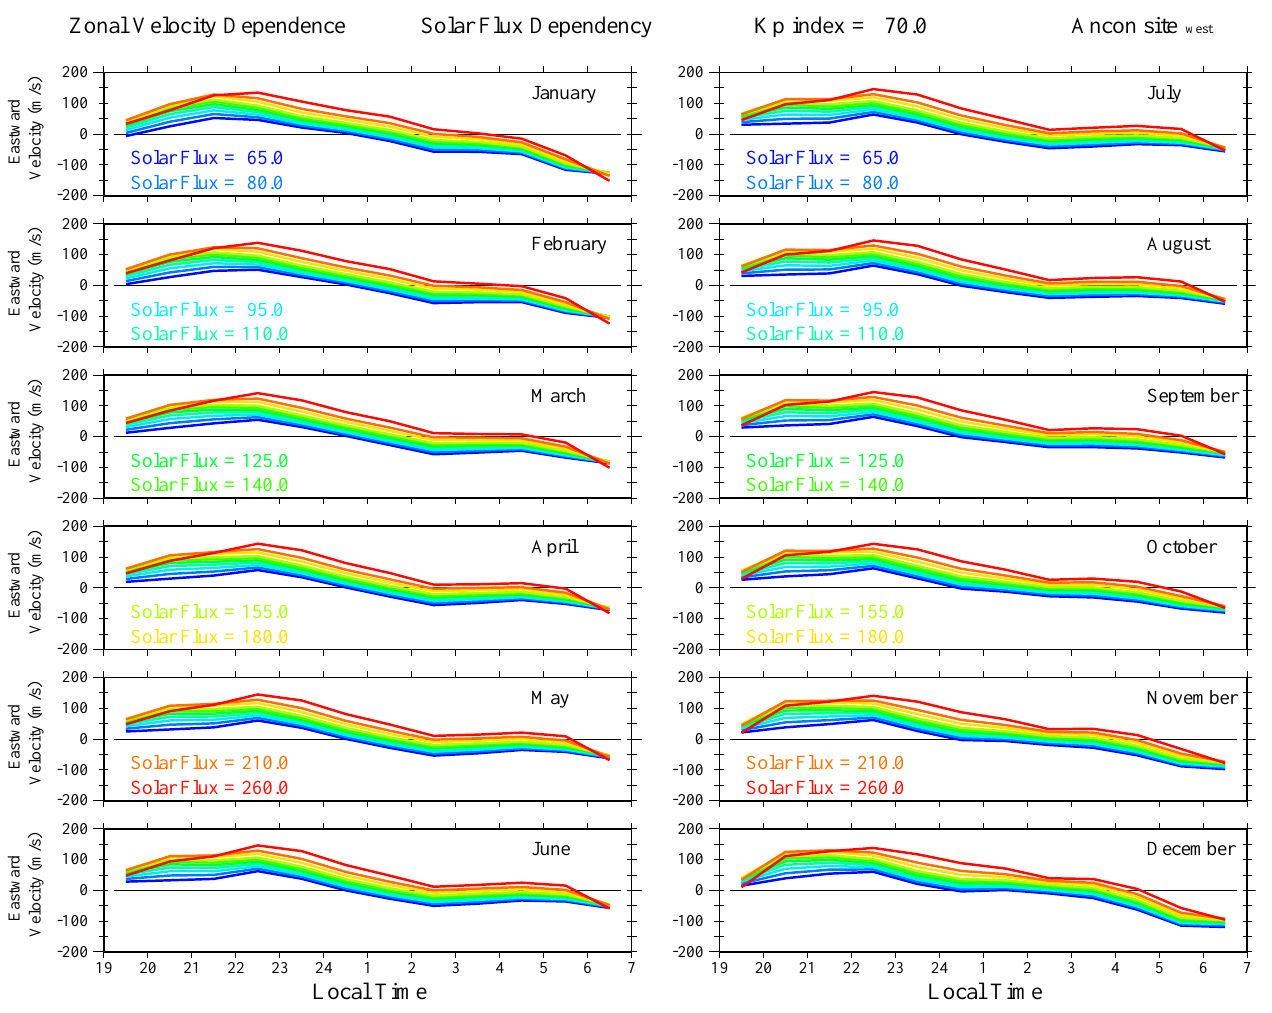
Fig. 6. (d) Ancon zonal drift dependence on solar flux, K p